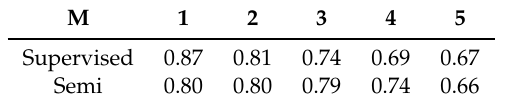
Table 11. Sensitivity Analysis (M).